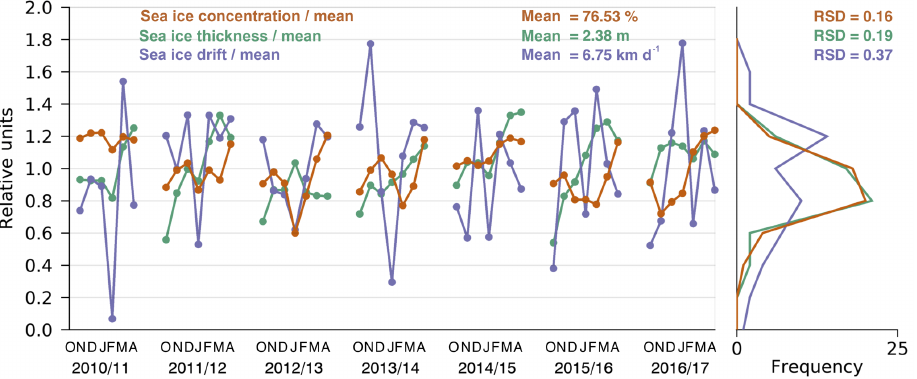
Figure 5. OSI SAF sea ice drift, ice thickness and ice concentration averaged over the entire Fram Strait gate, between October and April for winter seasons 2010–2011 to 2016–2017. Monthly values are divided by the mean of the data set for each parameter. The right box shows the corresponding histograms with the relative standard deviations